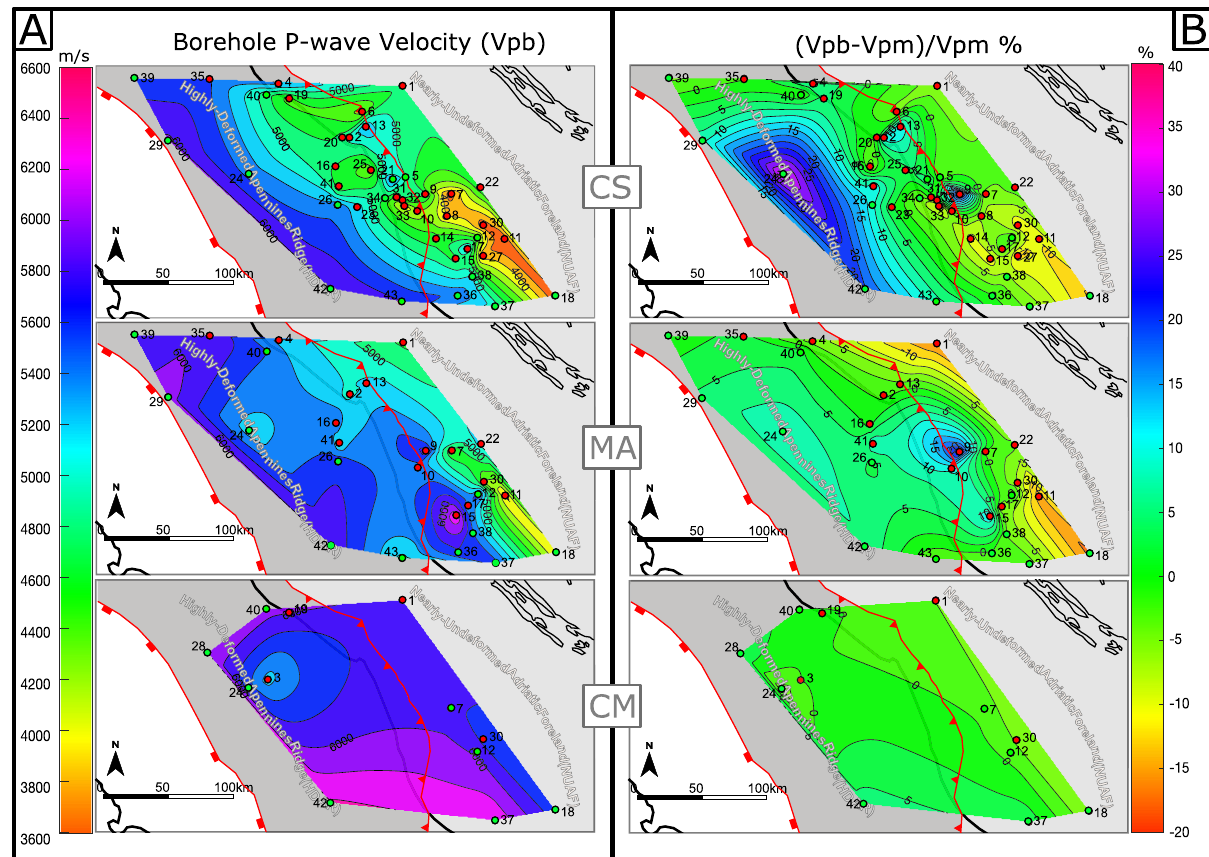
Figure 7. ( A ) Contour maps of the mean Vp recorded in the wells that drilled Calcare Massiccio (CM), Maiolica (MA) and Scaglia Group (SC). ( B ) Percentage Differences between the actual P-wave velocity (Vpb) recorded in each well and the modeled P-wave velocities (Vpm) using equations of Supplementary Table S3 for each investigate group (CM, MA and CS). Maps were generated by using Matlab (R2020b, https:// www. mathw orks. com) and then edited with Inkscape (1.0.2, https:// www. inksc ape. org) graphic